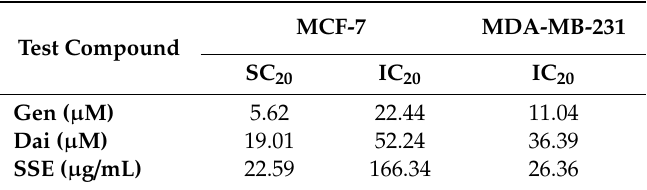
Table 1. The concentrations of Gen, Dai, and SSE used in the proteomic experiments. The concentrations were selected based on the MTT assay, as described in our previous study [11]. Test Compound